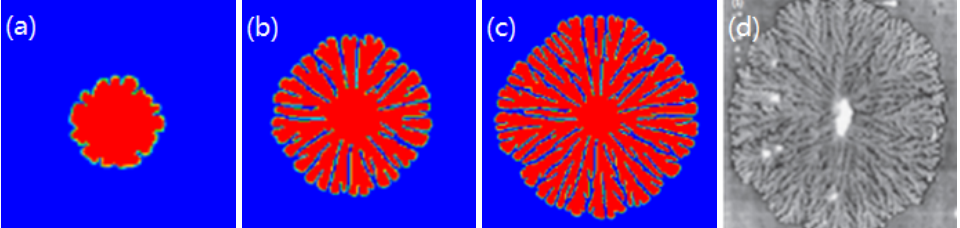
Figure 5. When K 0 = 1.4, the morphology of spherulite is obtained by numerical simulation. (( a – c ) are the numerical simulation results with time iteration steps of 1000, 3000 and 5000, respectively. ( d ) is the experimental